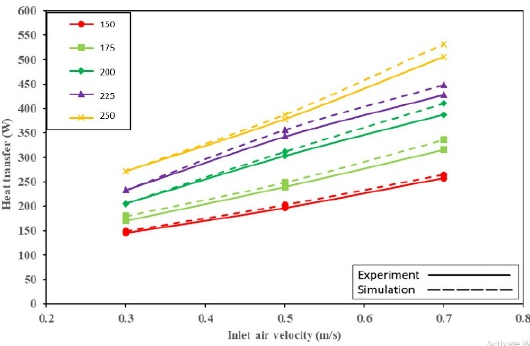
Figure 11. Heat transfer capacity comparison between experimental and numerical results for the evaporator end of the heat exchanger.